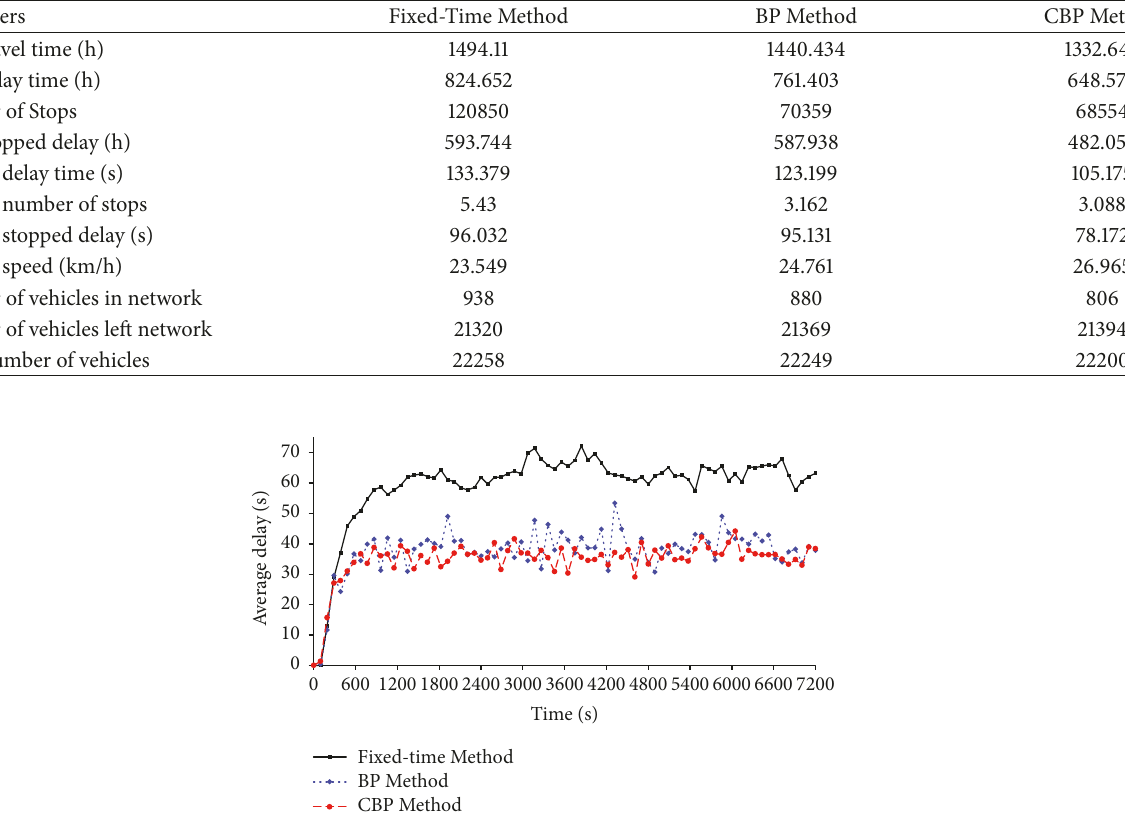
Table 2: Traffic network performance comparison.